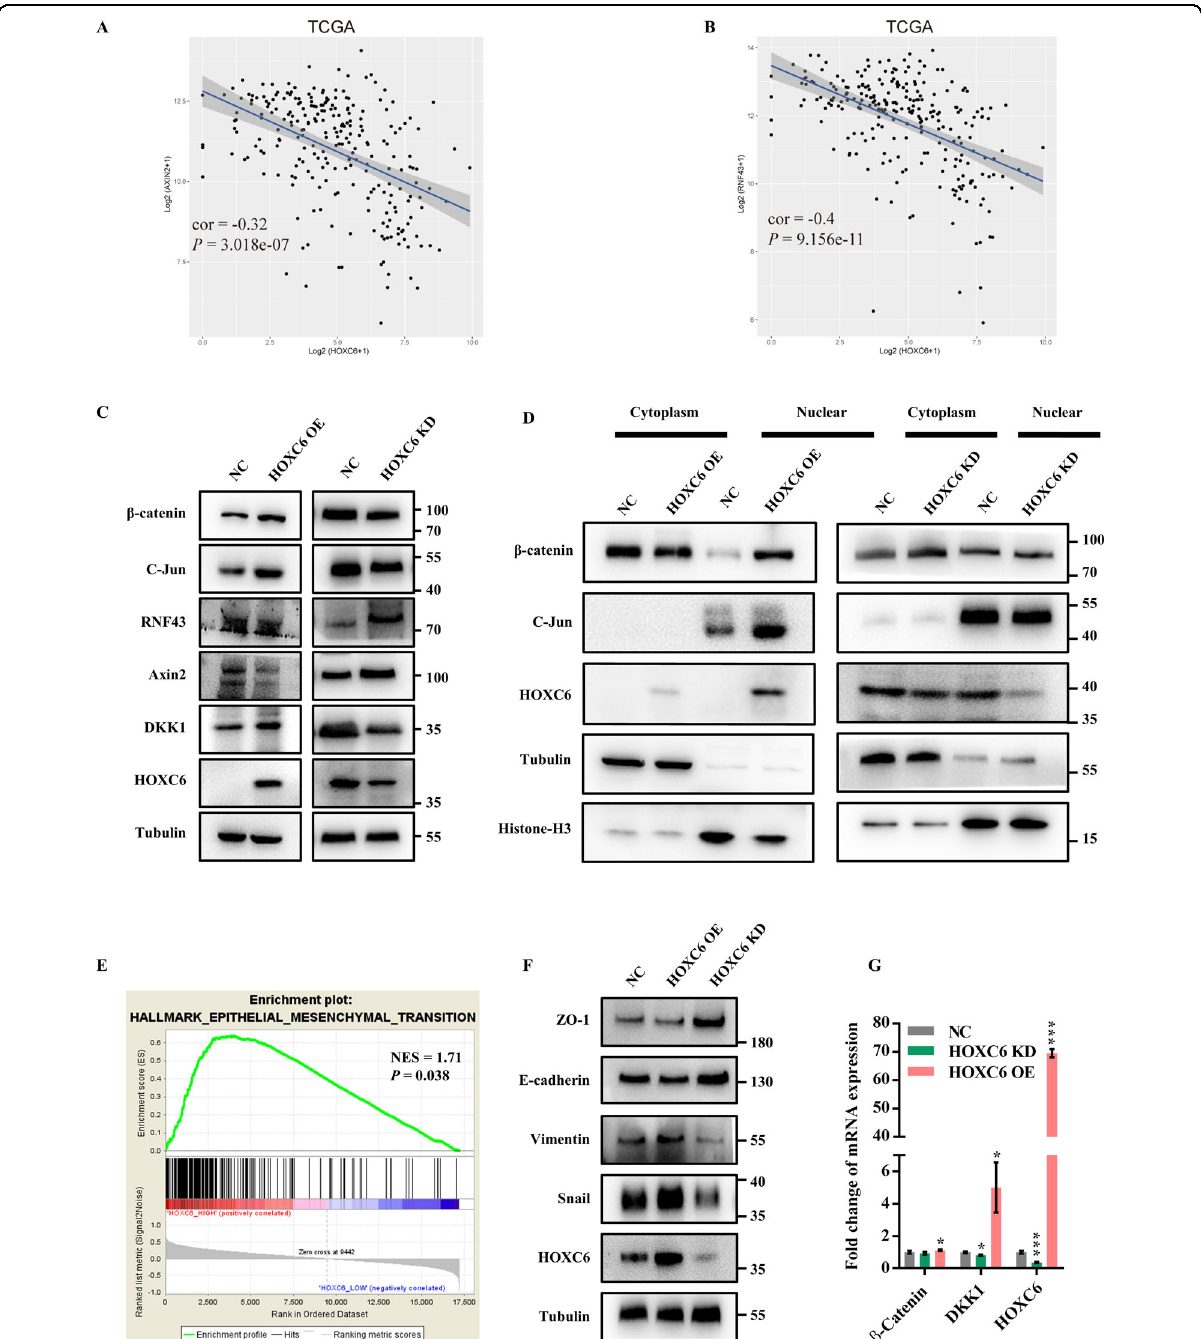
Fig. 4 HOXC6 contributes to activation of Wnt/ β -catenin pathway and EMT. A Pairwise correlation between Axin2 and HOXC6 using TCGA expression pro fi les. B Pairwise correlation between RNF43 and HOXC6 using TCGA expression pro fi les. C Expression of β -catenin, c-Jun, RNF43, Axin2, DKK1, and HOXC6 was evaluated by WB in whole-cell lysates of HOXC6-OE, HOXC6-KD, and their control groups in the HCT116 cell line. D The expression of β -catenin, c-Jun, and HOXC6 was evaluated in the cytoplasm and nucleus of HCT116 cells in the HOXC6-OE, HOXC6-KD, and control groups. Tubulin was used as a cell plasma protein and whole-cell protein loading control. Histone-H3 was used as a nuclear protein loading control. E GSEA showed that the EMT process was signi fi cantly enriched in the HOXC6-overexpressing group using TCGA dataset. F Protein expression of ZO-1, E-cadherin, vimentin, snail, and HOXC6 in three different treated HCT116 groups. G Relative mRNA expression of β -catenin, DKK1, and HOXC6 in the NC, HOXC6-KD, and HOXC6-OE groups in HCT116 cells. *: P < 0.05; ***: P <